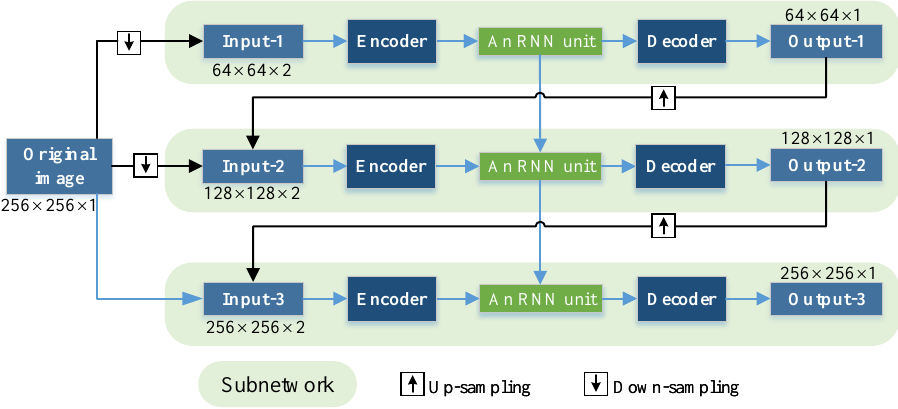
Figure 6. Overall architecture of